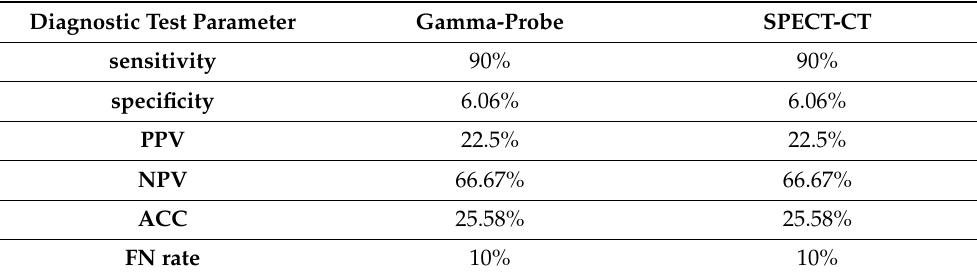
Table 2. Diagnostic values of SLN detection